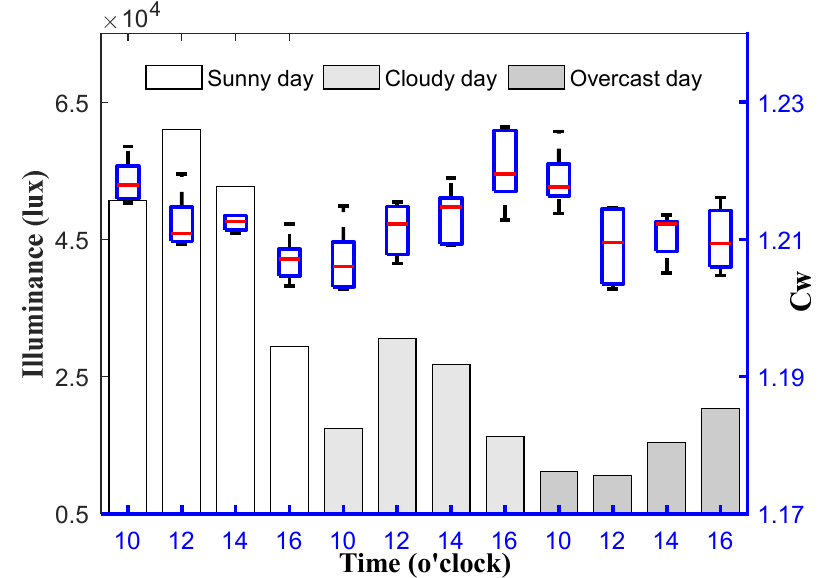
Table 1. Illuminance (lux) variation range of ambient light during tests.